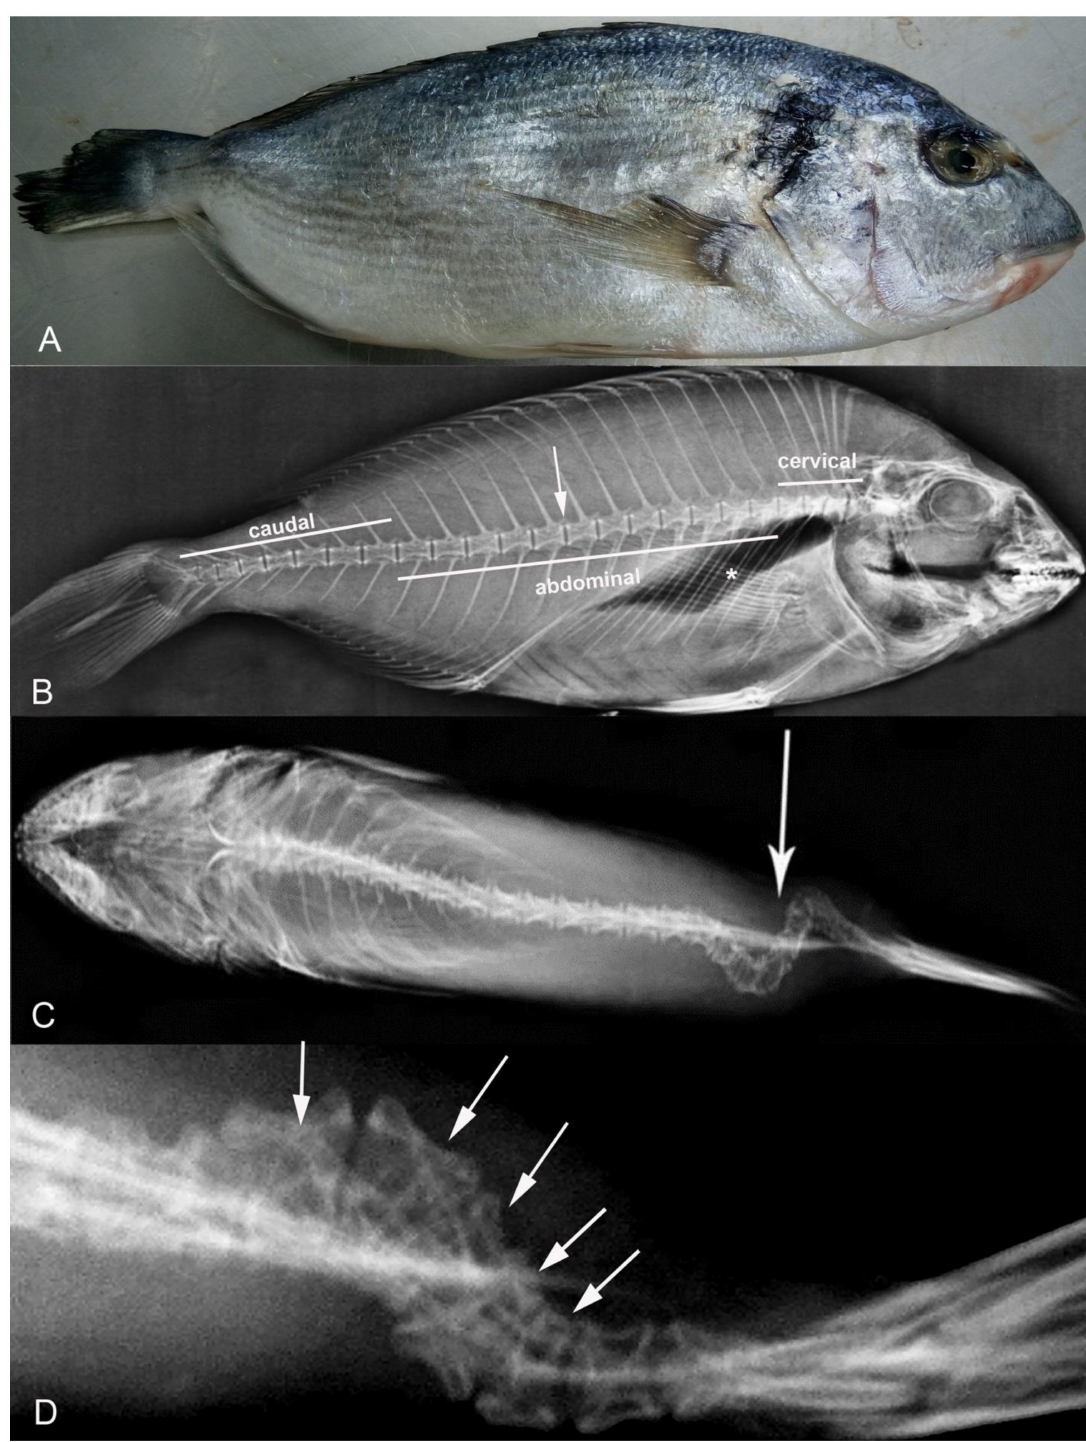
Figure 1. ( A ) Seabream with scoliosis at the caudal region. ( B ) X-ray of seabream without scoliosis. The cervical, abdominal, and caudal regions are shown. Inter-vertebrae space is highlighted with an arrow, whereas swim bladder is indicated with a star. ( C ) Apical X-ray of seabream with scoliosis. The scoliosis area is highlighted with an arrow. ( D ) Magnified apical X-ray of seabream caudal region with scoliosis. Deformed vertebrae with trapezoid shape are highlighted with